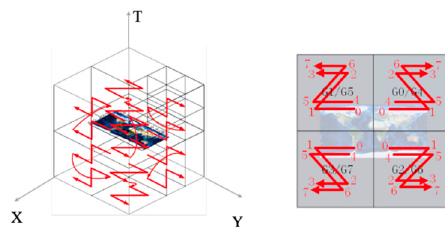
Figure 2. The subdivision and encoding method of the GeoSOT ST-index model.